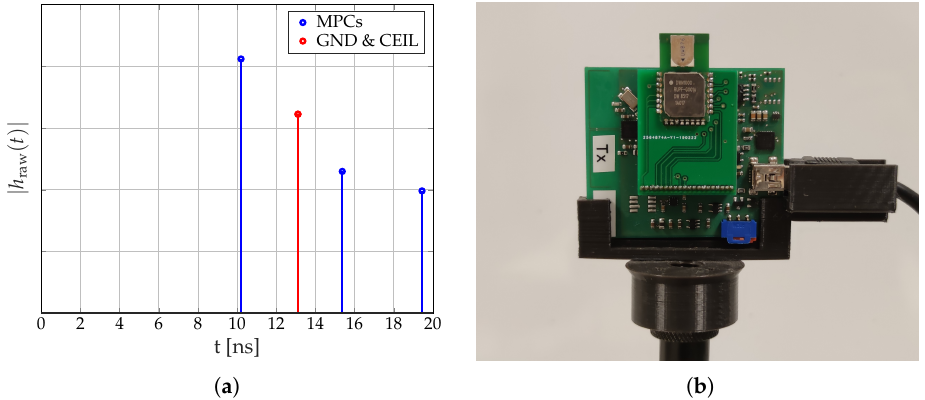
Figure 7. Theoretical multipath components and measurement equipment. ( a ) Estimated positions of the MPCs. ( b ) Photograph of the Measurement